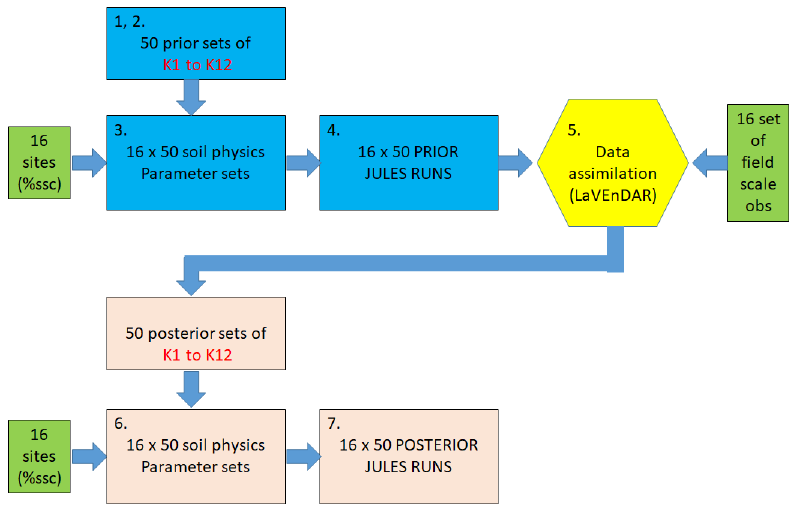
Figure 2. Schematic showing data assimilation experimental design; %ssc refers to site-specific fractions of sand, silt, and clay in the soil. In this study, only observations from 2017 (at each site) were used in the assimilation algorithm.